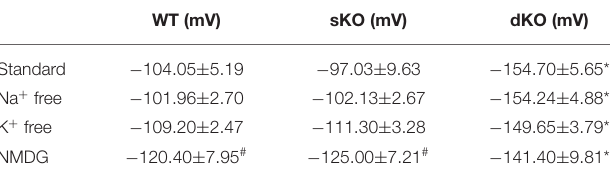
TABLE 1 | Resting membrane potential.